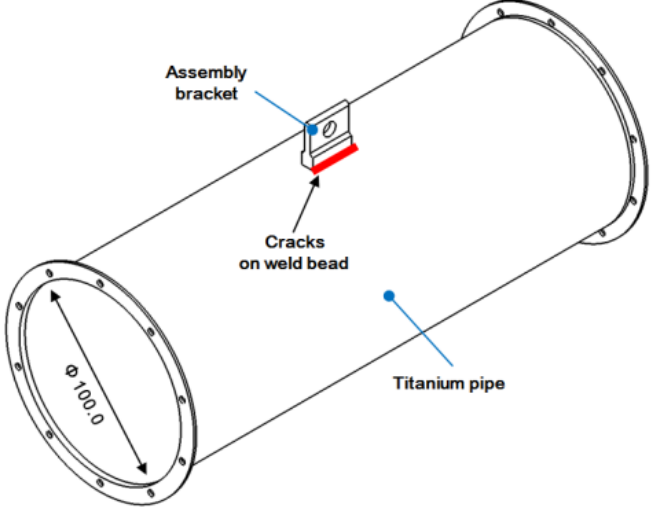
Figure 4. Illustration of cracks occurred Ti ‐ 3Al ‐ 2.5V pipe weldment. Table 3. Welding parameters of Ti ‐ 3Al ‐ 2.5V pipe.